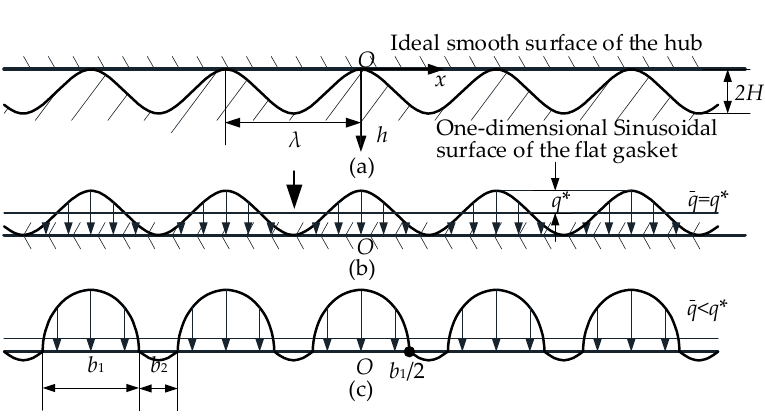
Figure 7. Contact schematic of the one-dimensional wavy surface. ( a ) The surface of the synthesized metal flat gasket; ( b ) The contact pressure of the surface completely compressed to a smooth state; ( c ) Discontinuous contact. H is the amplitude; q¯ is the mean contact pressure; q * is the amplitude of contact pressure; O is the contact center; b 1 is the actual sealing width; b 2 is the width of the leakage channel.